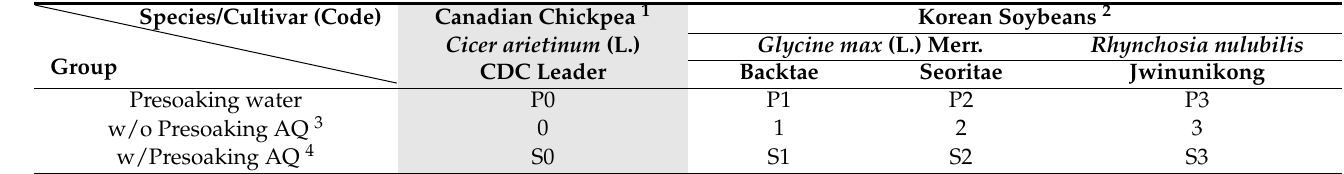
Table 1. AQ preparation